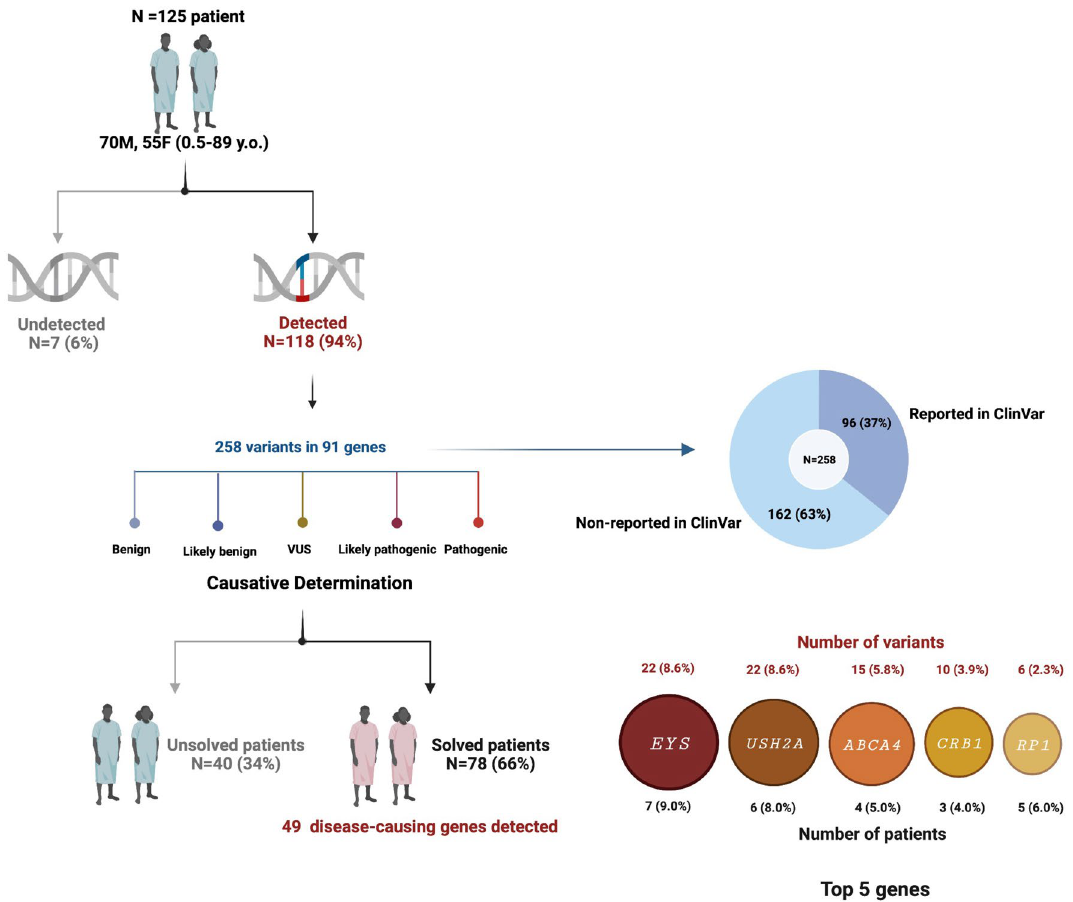
Figure 1. WES data of 125 Thai patients with IRD. Variants were detected in 94% of the patients. Based on variant classification, 49 genes were determined to cause diseases in 66% of the patients, with the EYS, USH2A, ABCA4, CRB1 , and RP1 showing the highest prevalence. This figure was created using